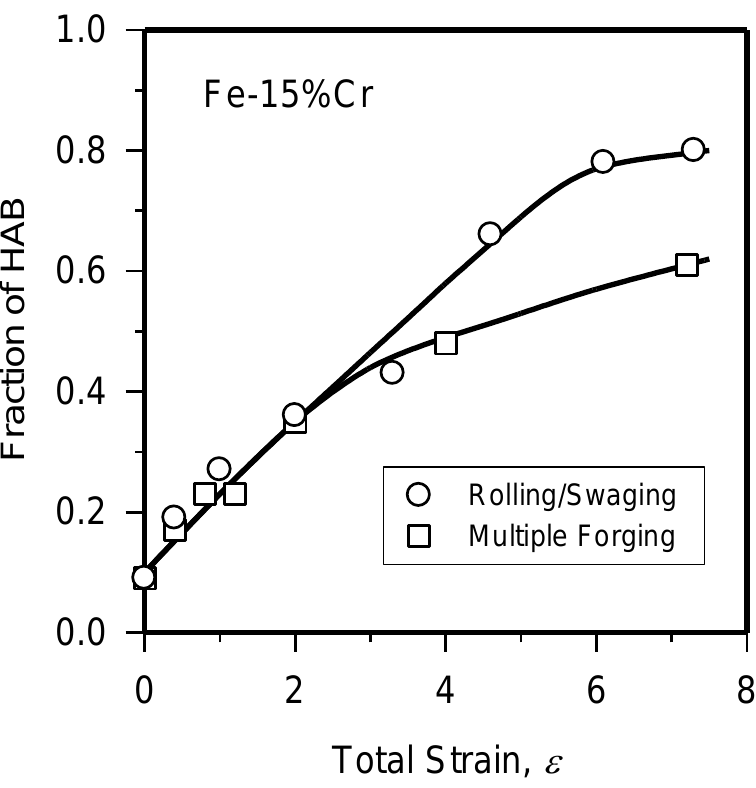
Figure 23. Effect of processing method on the fraction of strain-induced high-angle grain boundaries in a Fe-15%Cr stainless steel [39].